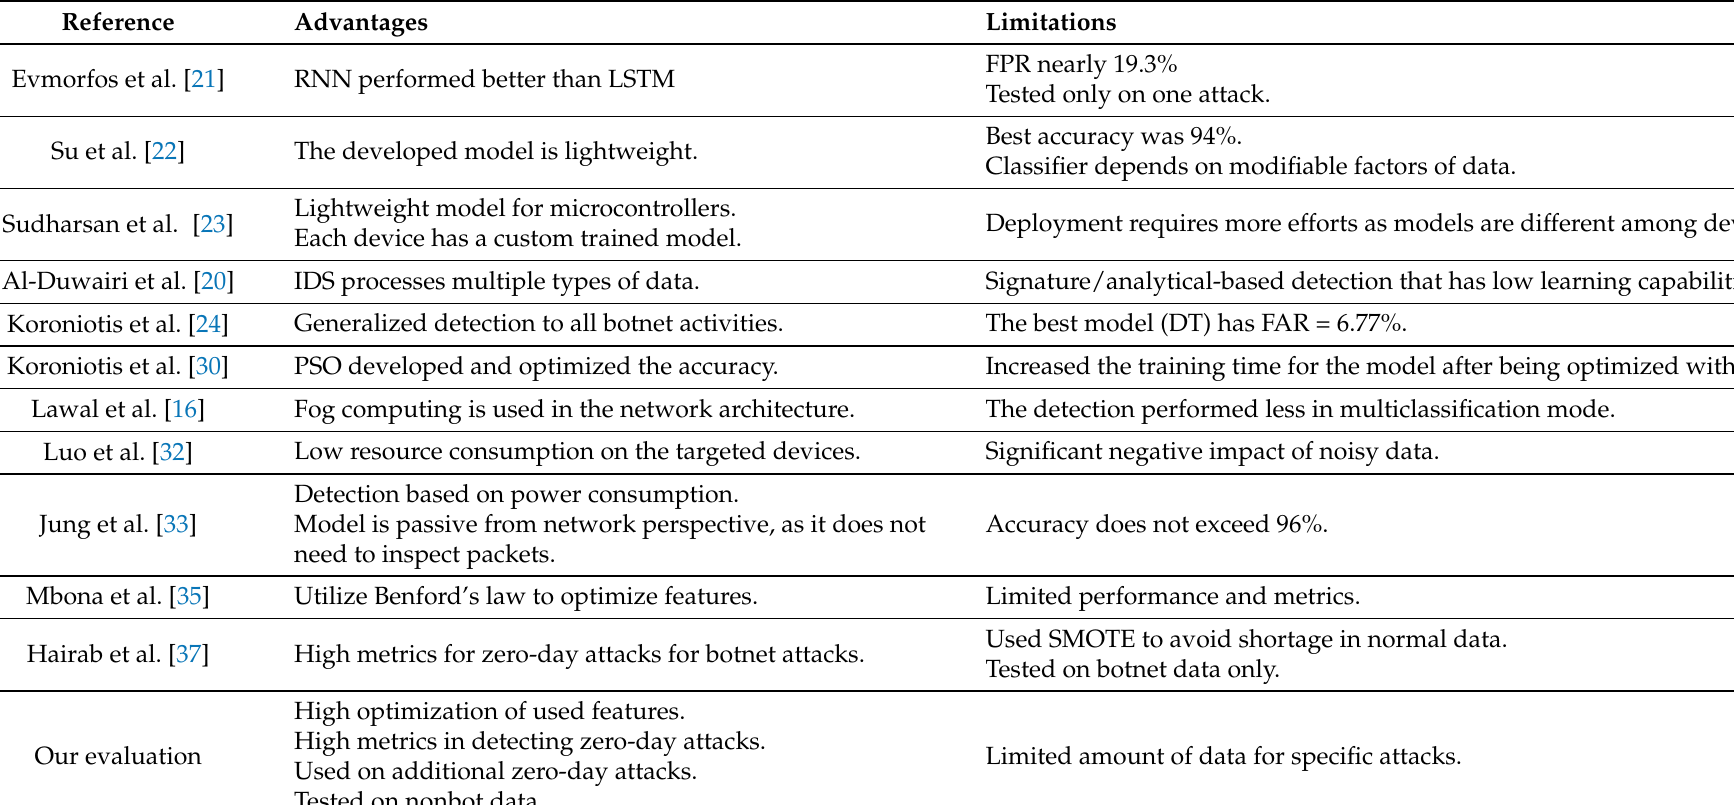
Table 2. State-of-the-art comparison between the reviewed approaches in detecting IoT attacks and our